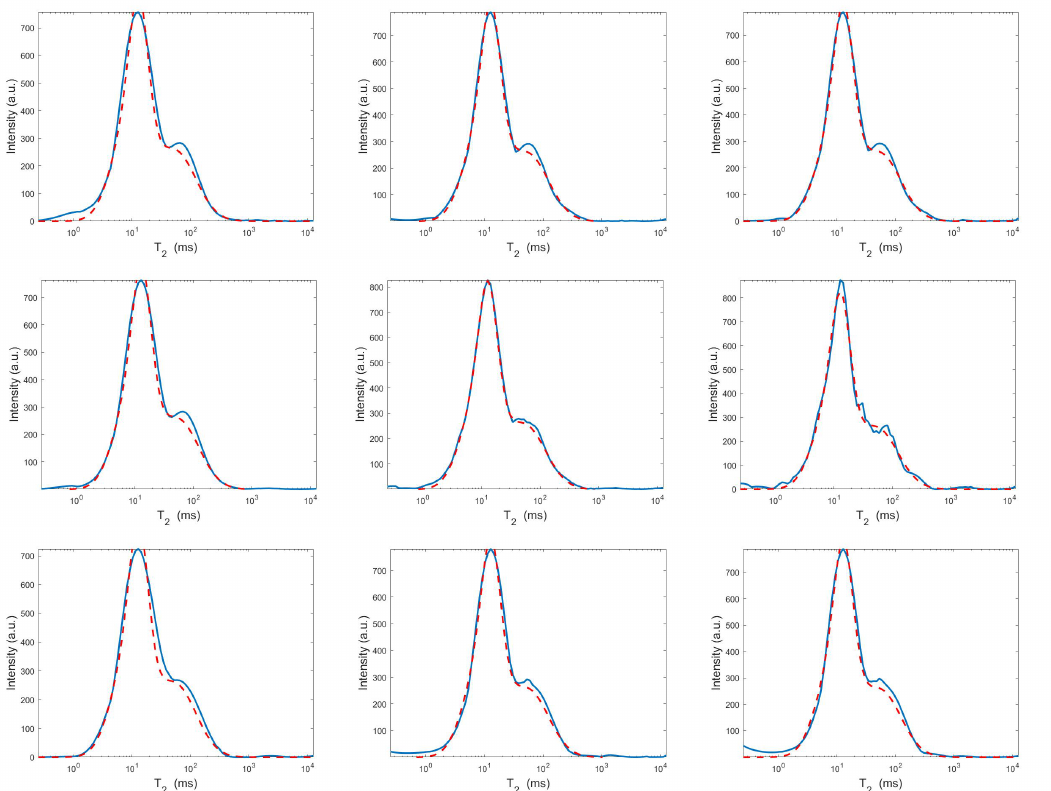
Figure 9. Projections along the T 2 dimension from the Hybrid ( top row ), Tikhonov ( middle row ) and VSH ( bottom row ) models for α = 1 ( left column ), α = 10 − 2 ( middle column ) and α = 10 − 4 ( right column ). The red dashed and blue continuous lines respectively represent the exact projections and the computed ones.